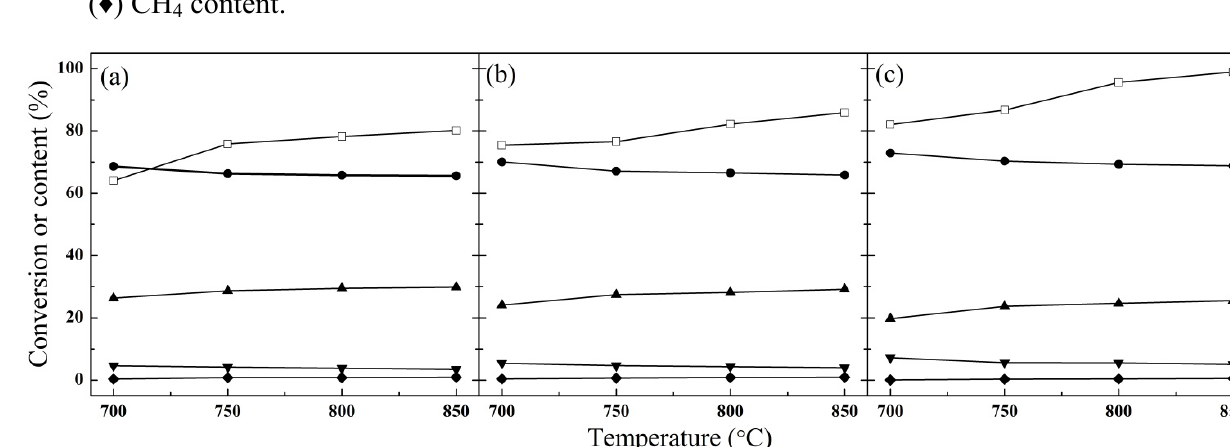
(1 wt%)/SBA-15; and ( c ) Ni-CeO 2 content; ( ▲ ) CO content; ( ▼ ) CO 2